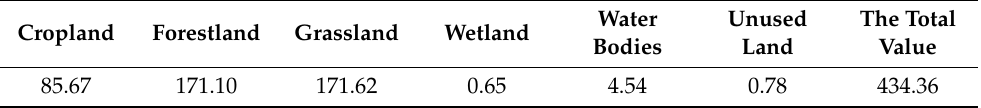
Water Unused The Total Bodies Land Value